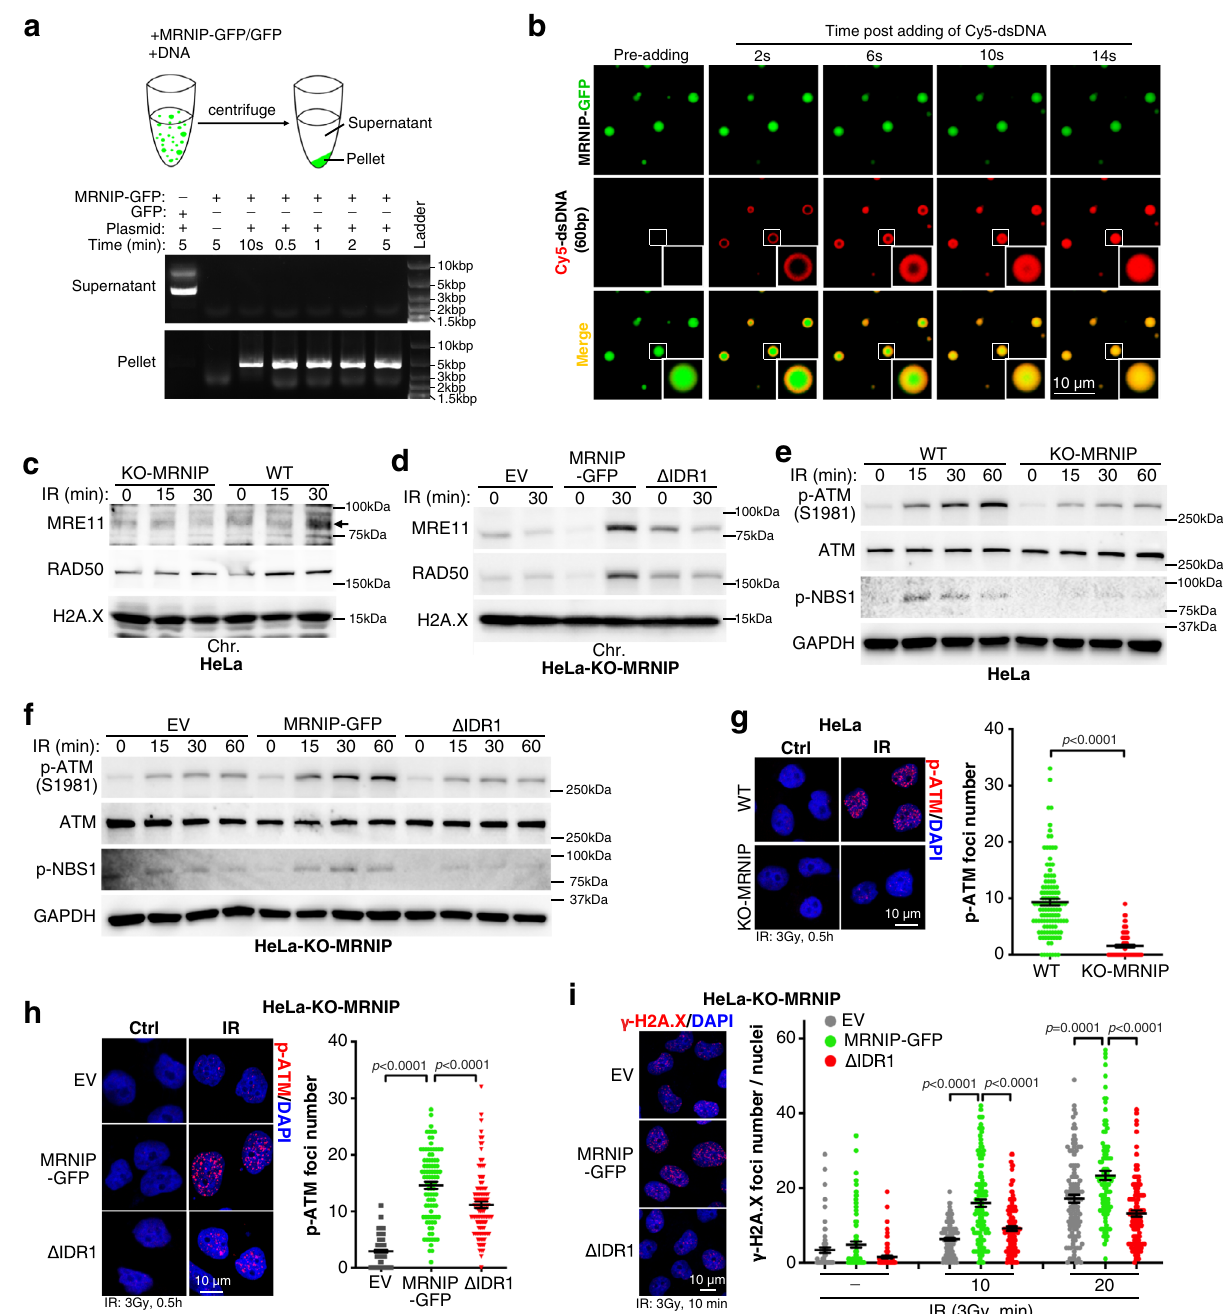
Fig. 5 MRNIP condensates accelerate the MRN complex loading and DNA damage response. a , b MRNIP condensates incorporated DNA from solutions within 10 s. Ten micromolar MRNIP was incubated with 15 ng/ µ L plasmid DNA or 0.5 µ M Cy5-dsDNA in buffer containing 150 mM NaCl, pH 7.4. c MRNIP depletion reduced radiation-induced MRN complex binding to chromatin. d The impact of wild-type or IDR1-deleted MRNIP on the radiation-induced binding of the MRN complex to DNA. For ( c , d ), chromatin was fractionated at the indicated time after irradiation (10 Gy). EV, empty vector; Δ IDR1, MRNIP- Δ IDR1-GFP. e , f The impact of MRNIP condensates on radiation-induced ATM and NBS1 phosphorylation. IR: 3 Gy. g , h IF assays were performed to analyse the impact of MRNIP on radiation-induced ATM phosphorylation. HeLa cells were irradiated with 3 Gy. Data are presented as means± SEM. Two- tailed unpaired Student ’ s t test. g n = 116 (WT), n = 77 (KO-MRNIP). h n = 107 (EV), n = 93 (MRNIP-GFP), n = 103 ( Δ IDR1). i IF assays were performed to analyze the impact of MRNIP on radiation-induced γ -H2A.X phosphorylation. HeLa cells were exposed to 3 Gy X-ray. Data are presented as means ± SEM. IR - : n = 69 (EV), n = 87 (MRNIP-GFP), n = 87 ( Δ IDR1); IR 10 min: n = 124 (EV), n = 122 (MRNIP-GFP), n = 119 ( Δ IDR1); IR 20 min: n = 111 (EV), n = 96 (MRNIP-GFP), n = 112 ( Δ IDR1). Two-tailed unpaired Student ’ s t test. For ( c – i ), HeLa-KO-MRNIP cells stably expressing sgRNA-resistant MRNIP-GFP, MRNIP- Δ IDR1-GFP ( Δ IDR1) and empty vector (EV) were used.